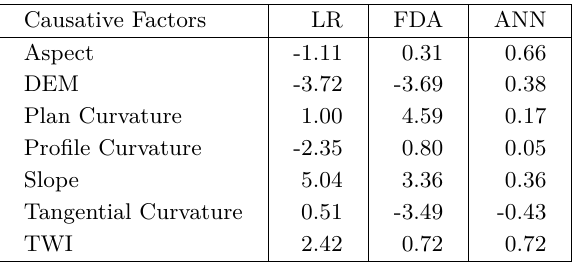
Table 1. Weights calculated from different models using imbalanced data